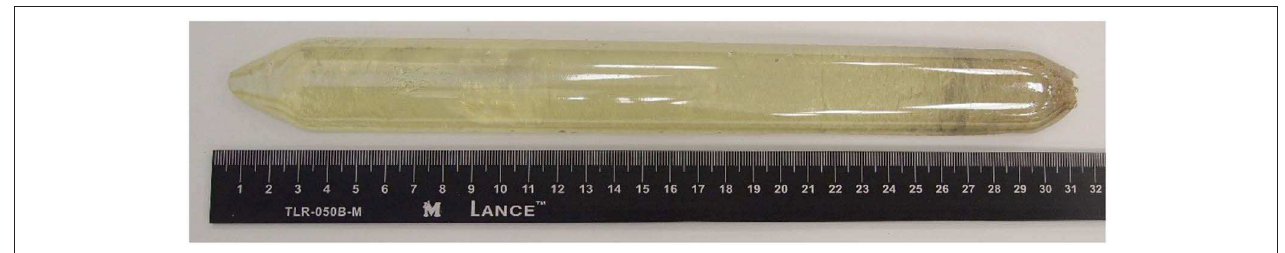
FIGURE 3 | TlBr ingot grown by horizontal zone